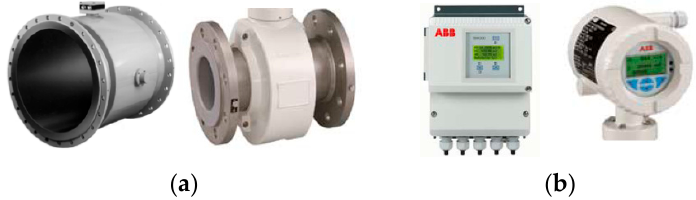
Figure 1. Electromagnetic flowmeters components: ( a ) primary element; ( b ) convertor (adapted from [1]).